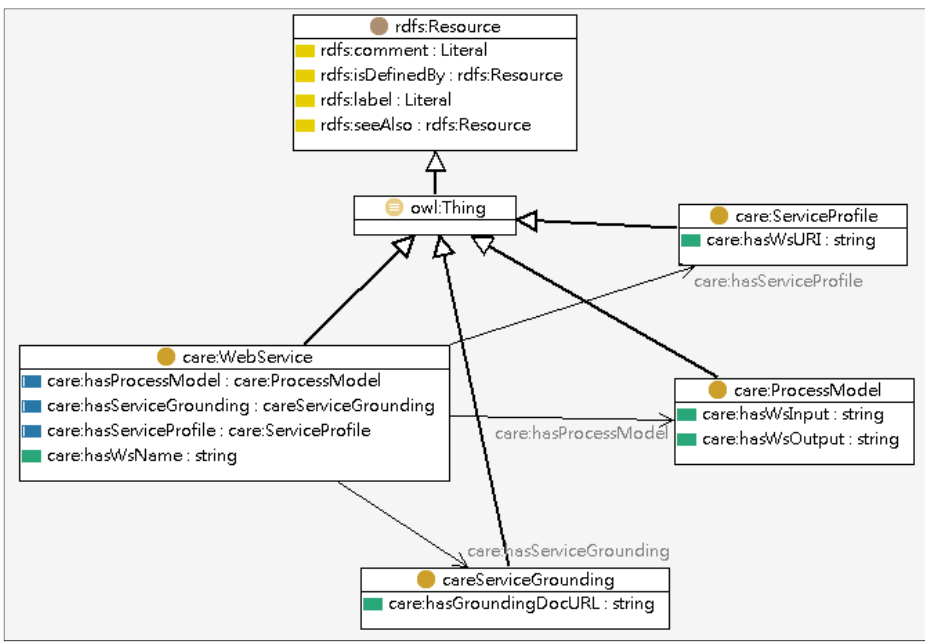
Figure 5. Partial model of the service